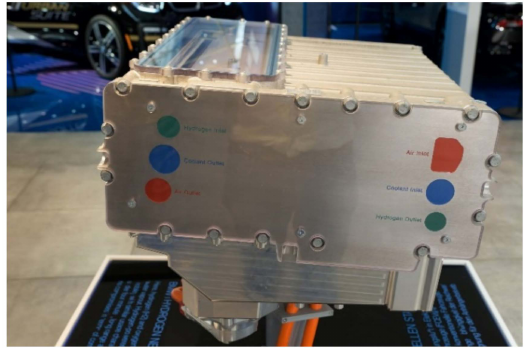
Figure 1. Prototype of a fuel cell for automotive